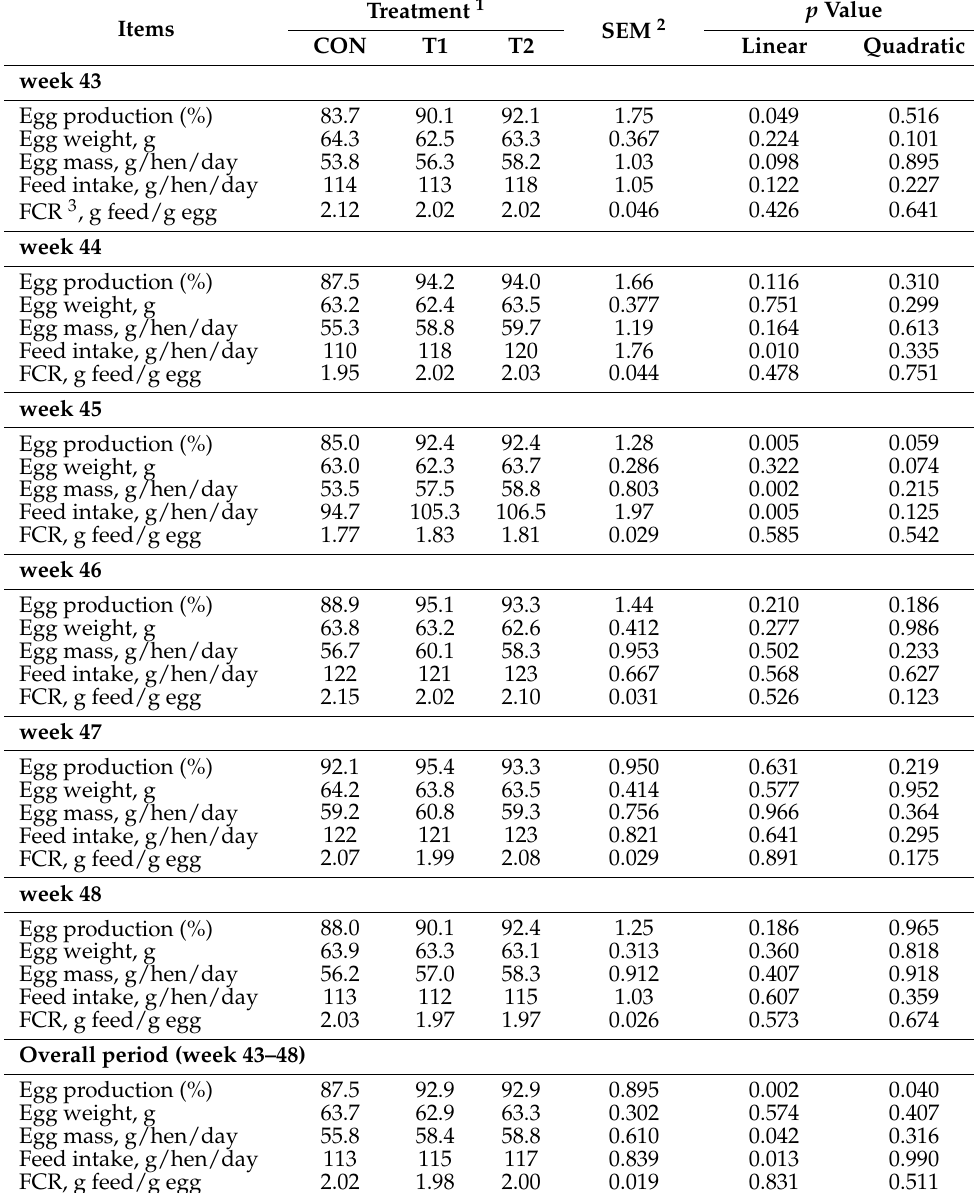
Table 4. Effect of dietary supplementation of fermented pine needle extract in egg production and feed conversion ratio of laying